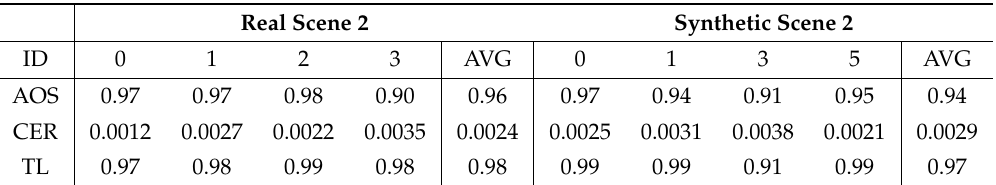
Table 3. Comparison of our system’s tracking performance on the second scene from our real dataset and its synthetic counterpart. IDs are assigned randomly and correspond to a single tracked worker